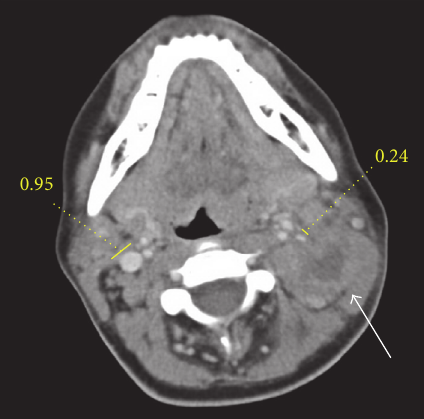
Figure 1: Computed tomography scan of the neck without contrast showing enlarged bilateral lymph nodes. On the patient’s left, the largest lymph node ( 4.1 × 2.7 cm; white arrow) has a central hypo- density ( 1.9 × 1.2 cm) consistent with fatty necrosis. Additionally, the right internal jugular (IJ) vein measured 0.95 cm in the greatest diameter whereas the left IJ vein was